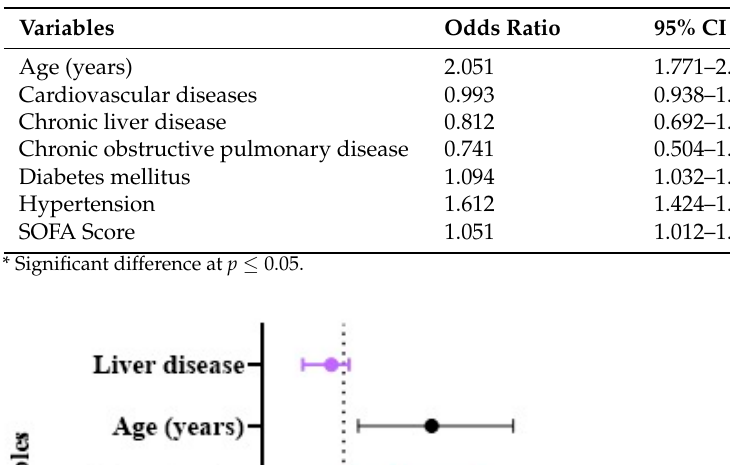
Table 5. Risk factors for acute kidney injury using univariate logistic regression analysis.